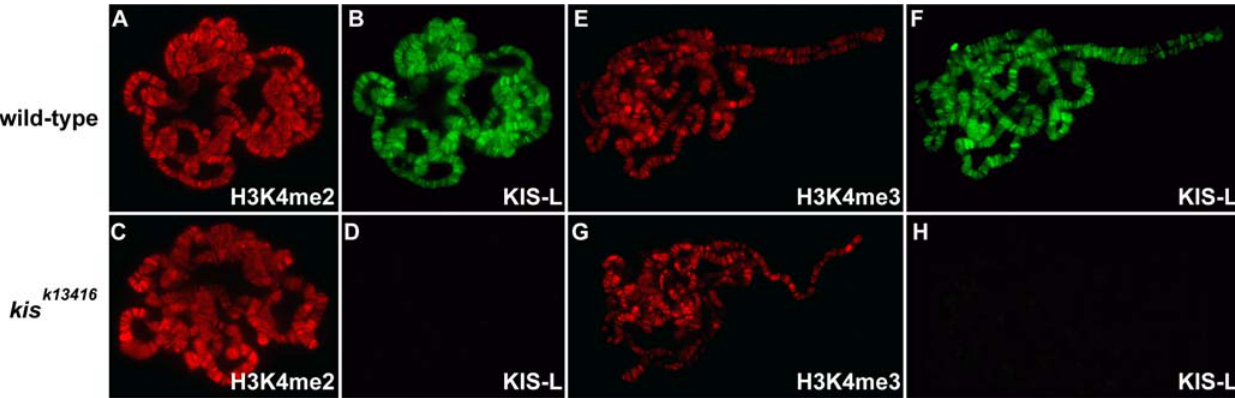
Figure 7. KIS-L is not a global regulator of H3K4 methylation. The distribution of H3K4me2 (A, C, red), KIS-L (B, D, F and H, green), and H3K4me3 (E, G, red) on salivary gland polytene chromosomes isolated from wild-type (A, B, E and F) and kis k13416 (C, D, G and H) larvae were detected by indirect immunofluorescence microscopy. The loss of KIS-L function does not cause obvious changes in the overall level or distribution of either H3K4me2 or H3K4me3.